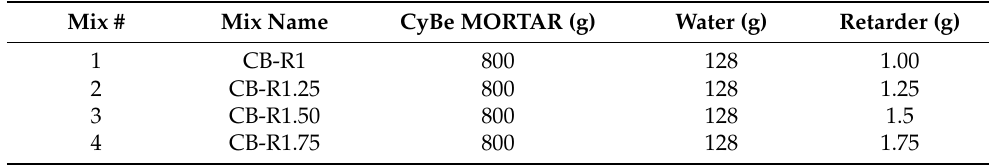
Table 1. Mortar mixture